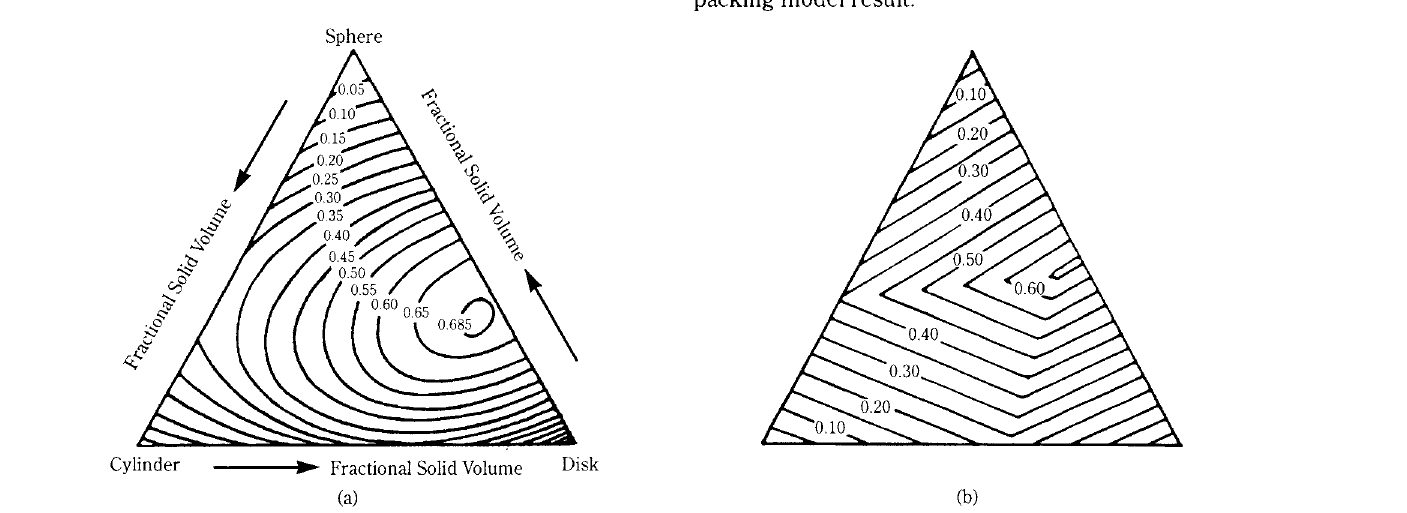
Fig. 11 Comparison between the measured (a) and calculated (b) specific volume variations for a disk-cylinder-sphere ternary system: disk,